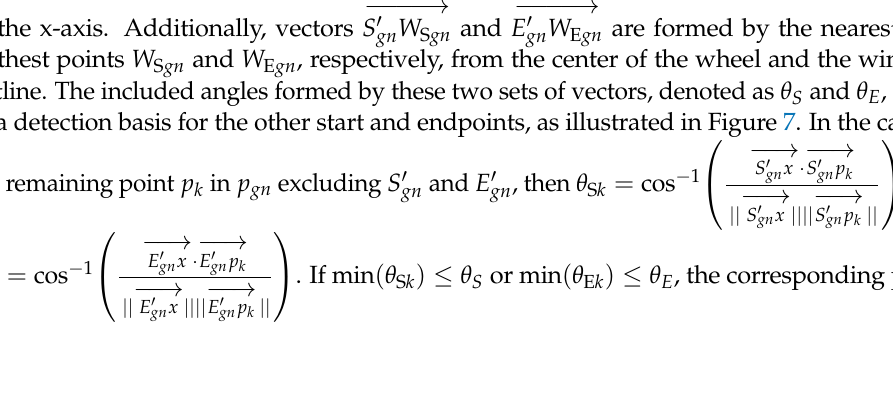
Figure 7. Radial position analysis. 𝑆 (cid:3034)(cid:3041)(cid:4593) 𝑥(cid:4652)(cid:4652)(cid:4652)(cid:4652)(cid:4652)(cid:4652)(cid:4652)(cid:4652)(cid:4652)⃗ and 𝐸 (cid:3034)(cid:3041)(cid:4593) 𝑥(cid:4652)(cid:4652)(cid:4652)(cid:4652)(cid:4652)(cid:4652)(cid:4652)(cid:4652)(cid:4652)⃗ are unit vectors. 𝑊 (cid:2903)(cid:3034)(cid:3041) is the point farthest from the center and 𝑊 (cid:2889)(cid:3034)(cid:3041) is the closest to the center. 𝜃 (cid:3020) and 𝜃 (cid:3006) are used to detect another start and endpoint.